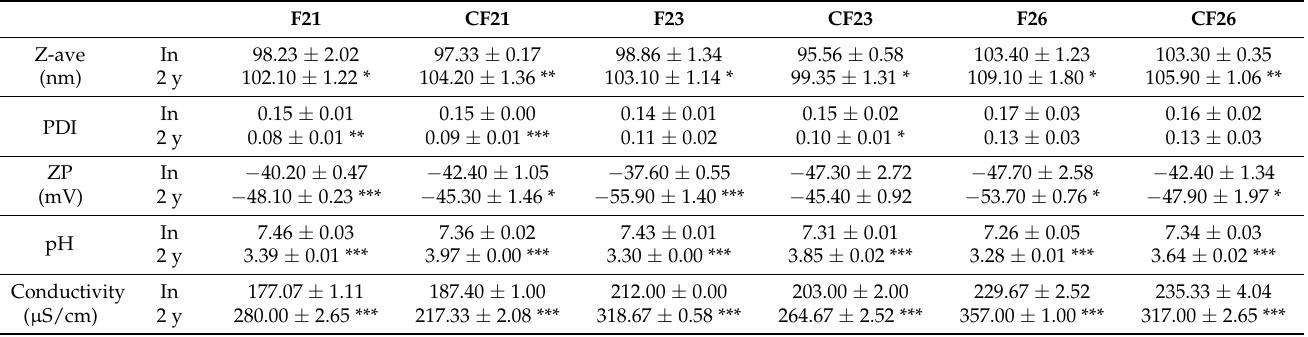
Table 6. Physicochemical parameters for fish oil nanoemulsions containing PEG2000-DSPE measured initially (In) and after two years of storage at room temperature (2 y).